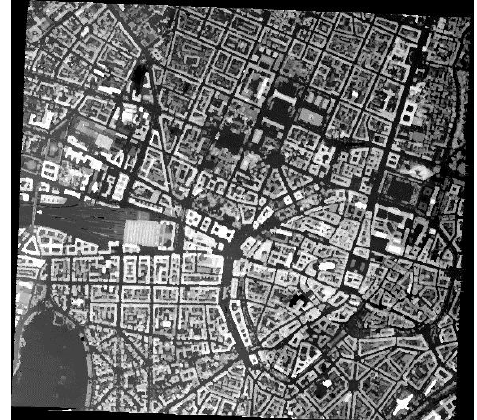
Figure 8: WorldView-2 DSM at 1m